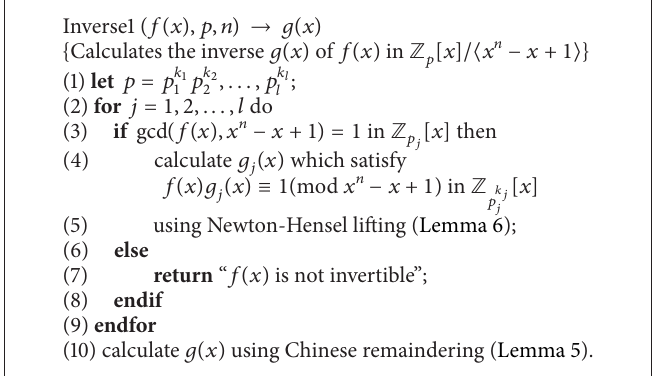
Algorithm 1: Finding inversion in Z 𝑝 [𝑥]/⟨𝑥 𝑛 − 𝑥 + 1⟩ for factorization of 𝑝